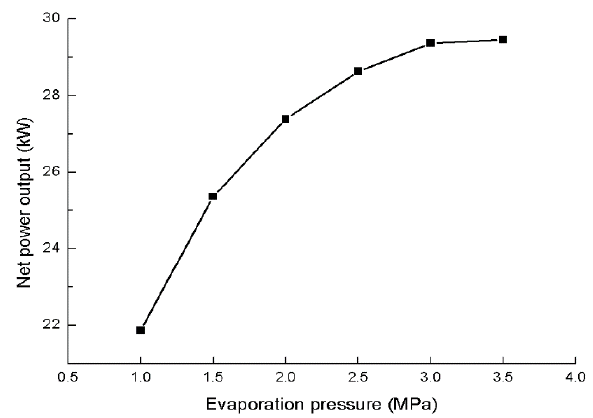
Figure 8. Influence of the evaporating pressure of the HT cycle on the net power output of the DORC system.